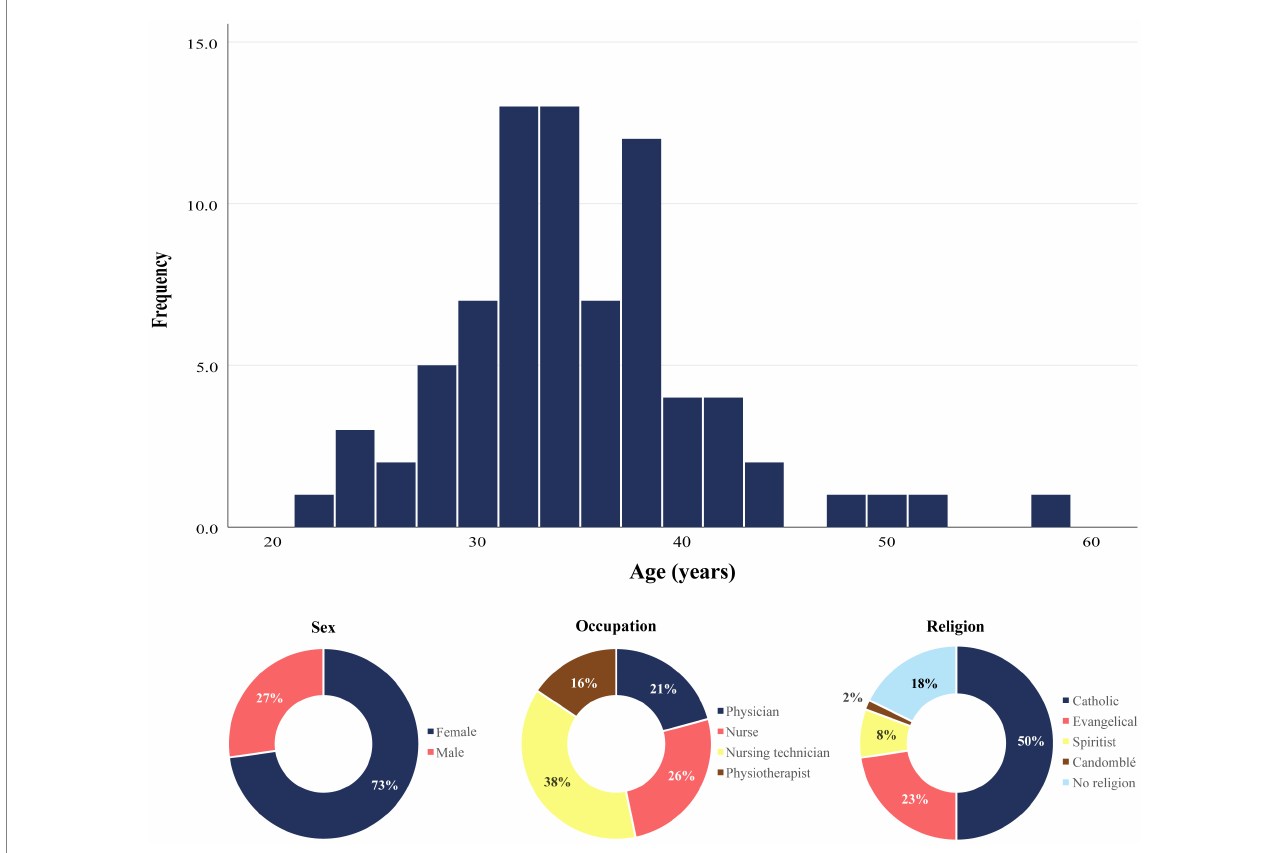
FIGURE 2 Population Characteristics. Upper panel: histogram depicting age distribution of the study participants at the baseline. Lower panel: Distribution of sex, occupation and religion types among the study participants. Data are frequencies of a total of 77 individuals who enrolled the study.